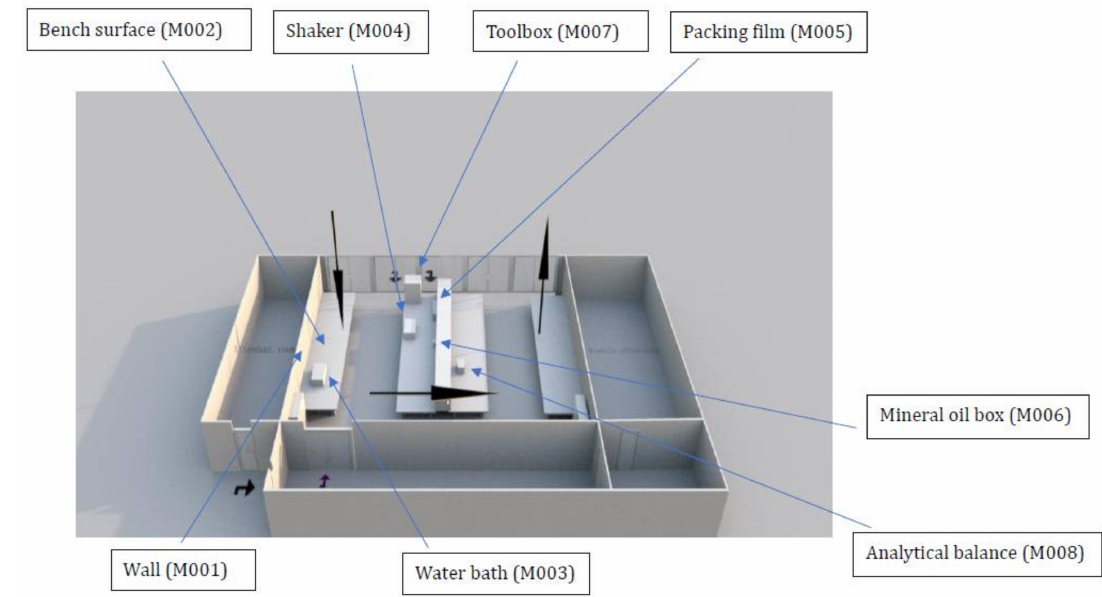
Figure 2. Laboratory layout and sample sites. The arrows in the laboratory indicate the air flow direction. The downward arrow on the left indicates the supply air coming out from the air diffusers and the upward arrow on the right points to the direction of the return air into the air-cooling units. The arrows shown outside the laboratory indicate the movement of the air into the laboratory. The room on the left of the laboratory is for the lab attendant and on right for the scientific officers. There are windows at the back of the laboratory. The windows are always kept